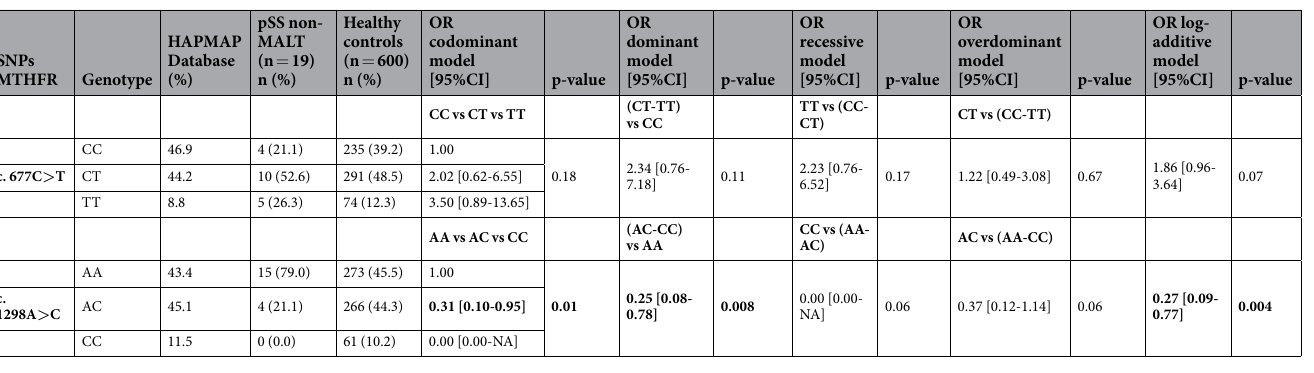
Table 2. Prevalence of MTHFR genotypes in pSS non-MALT and healthy control groups, adjusted by gender and age. Genotypes, OR and p-value for the five genetic models (codominant, dominant, recessive, overdominant and additive) were estimated with SNPstats software (statistically significant if p <